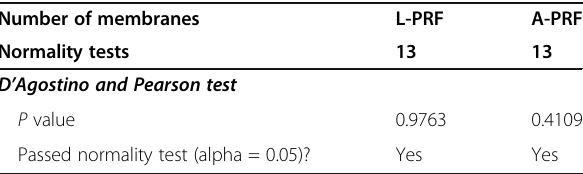
Table 1 Test for normal